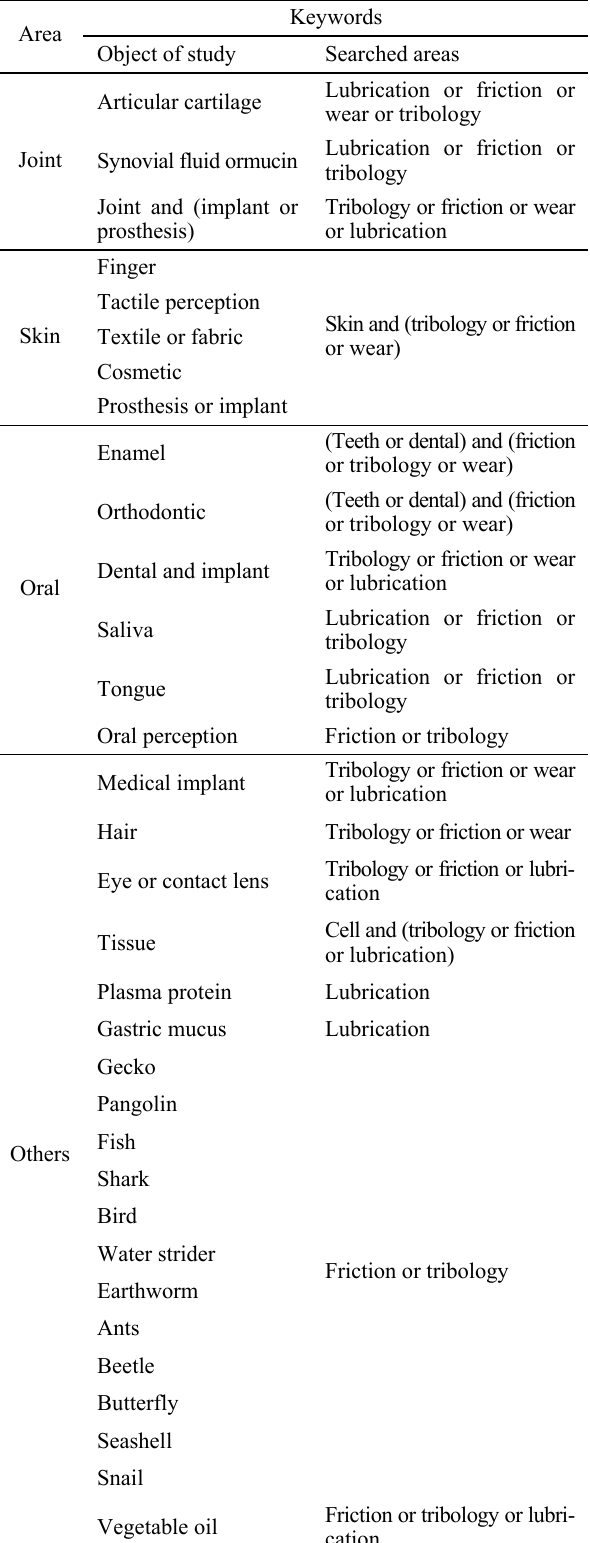
Table 3 Keywords and combinations used for the search from Web of Science.